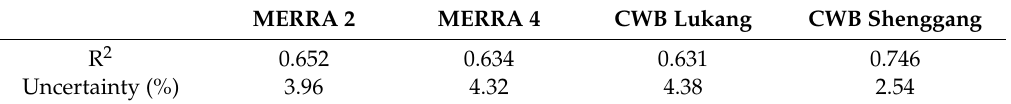
Table 10. Uncertainties in long-term correlations of different data sources as determined using MCP data from MERRA data of locations 2 and 4, and CWB data of Lukang and Shenggeng.